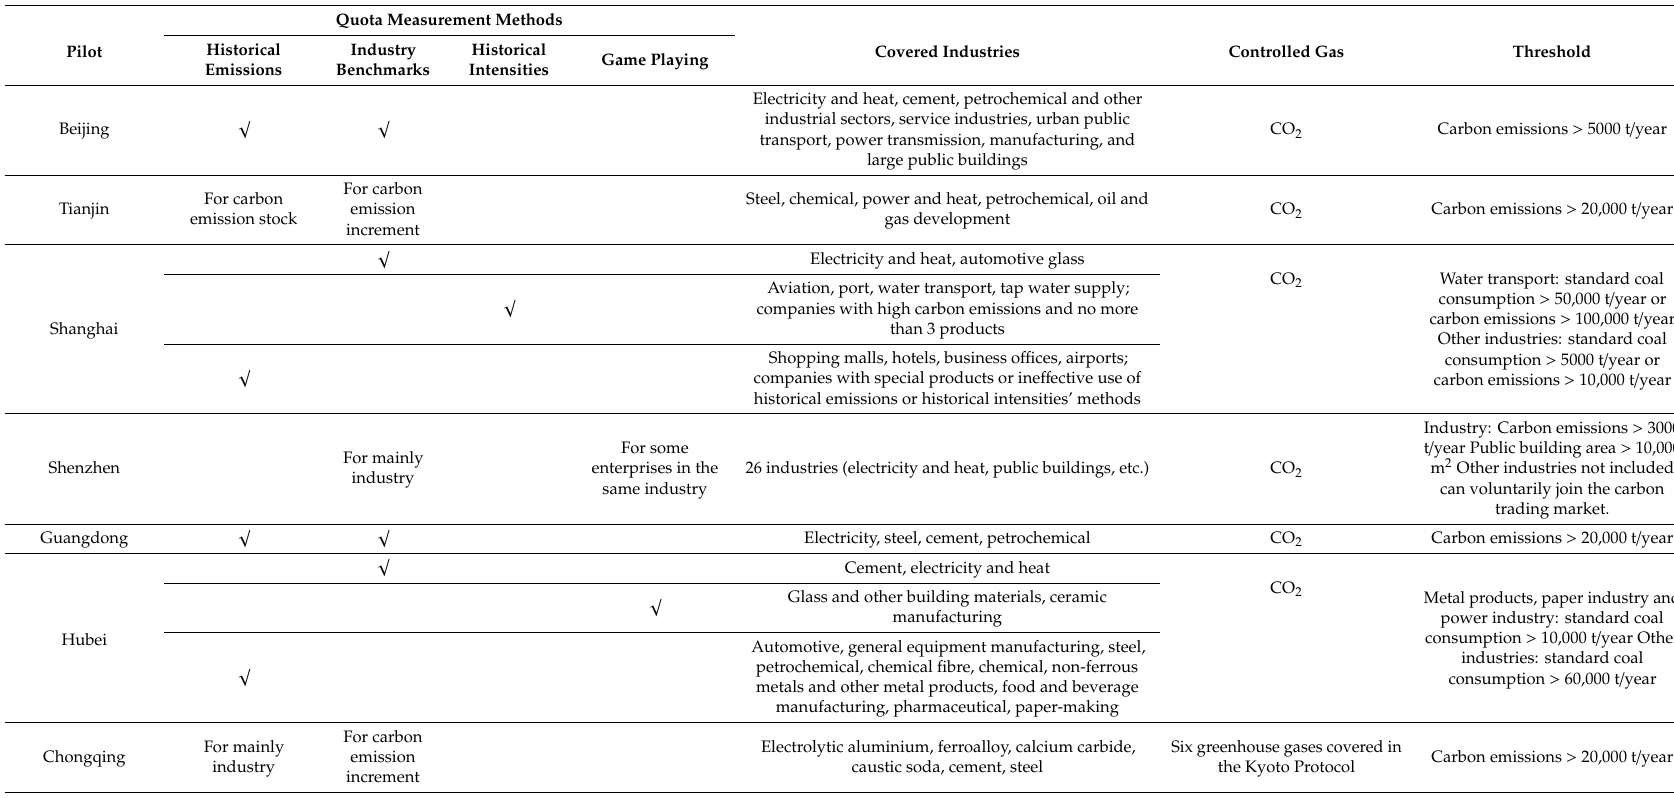
Table 1. Comparison of evaluating method, industry distribution, regulated emission, and admittance criterion among Chinese ETS pilots, EU ETS, and CA CAT.